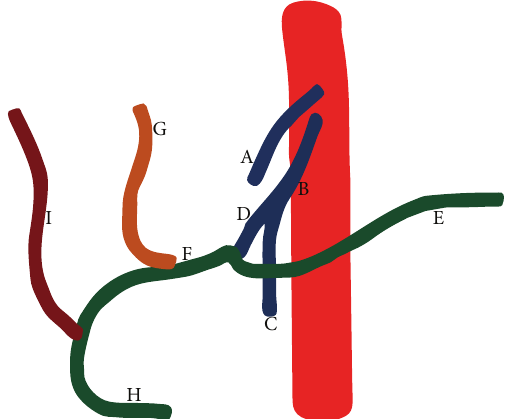
Figure 2: Illustration of the anatomic variant. Key: left gas- tric artery—A; celiacomesenteric trunk—B; superior mesenteric artery—C; coeliac trunk—D; splenic artery—E; common hepatic artery—F; left hepatic artery—G; gastroduodenal artery—H; right hepatic artery—I.